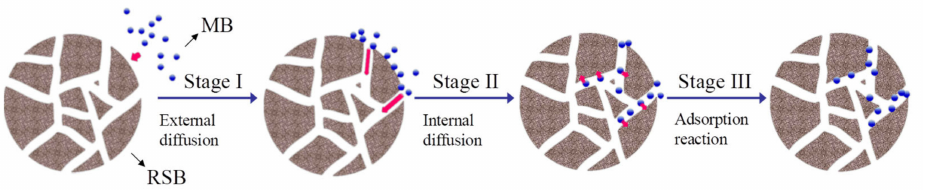
Figure 11. Adsorption process of MB onto